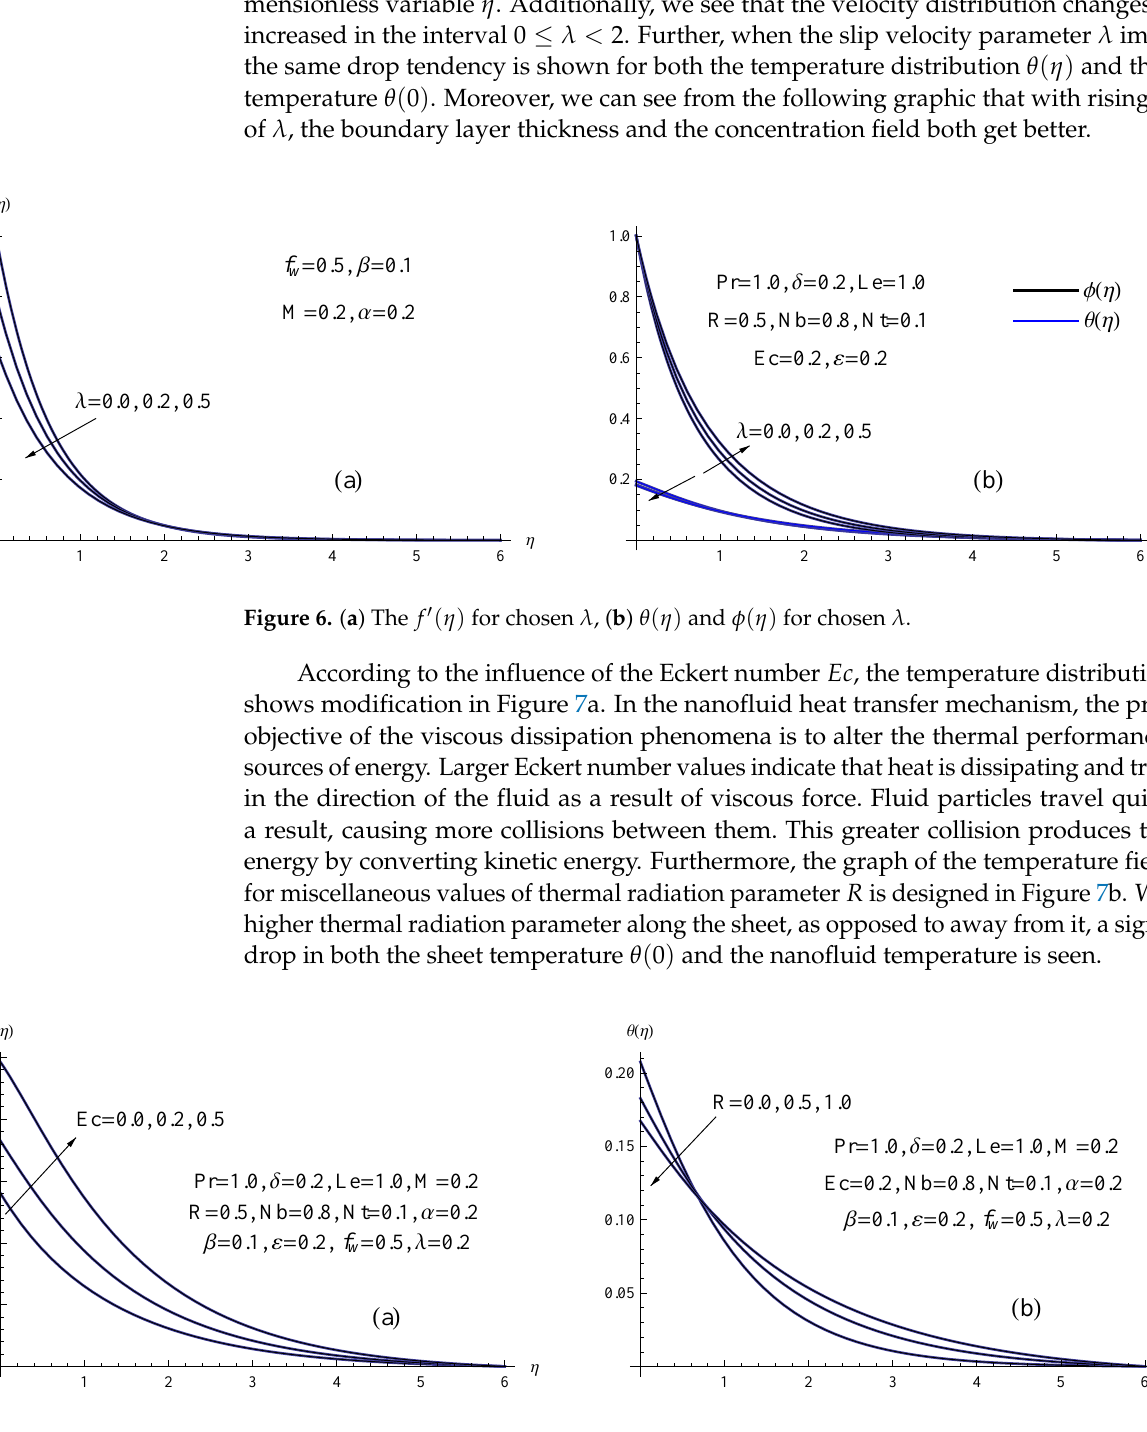
Figure 7. ( a ) θ ( η ) for chosen Ec ( b ) θ ( η ) for chosen R . Figure 8 shows how the surface-convection parameter δ affects the temperature dis- tributions θ ( η ) in the region of the thermal boundary layer. The nanofluid temperature θ ( η ) is seen to dramatically increase along the sheet wall but only modestly rise away from the sheet, especially when η is greater than 4.0. As a result, the nanofluid along the sheet warmed due to higher values of the surface-convection parameter, which thickened the thermal boundary layer. Figure 8b illustrates the graphical behavior of the nanofluid’s dimensionless temperature for various values of the thermal conductivity parameter ε . It